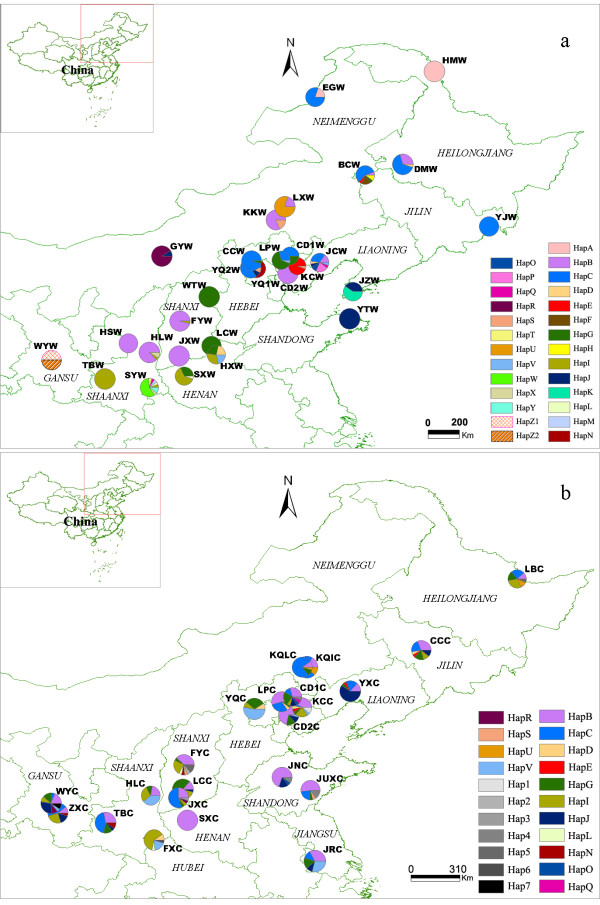
Geographic distribution and frequencies of chloroplast haplotypes in wild Scutellaria baicalensis and Scutellaria rehderiana (WYW) (a) and cultivated Scutellaria baicalensis (b) populations. Population abbreviations are the same as Table 1. The pie sizes of populations are proportional to their sample sizes.